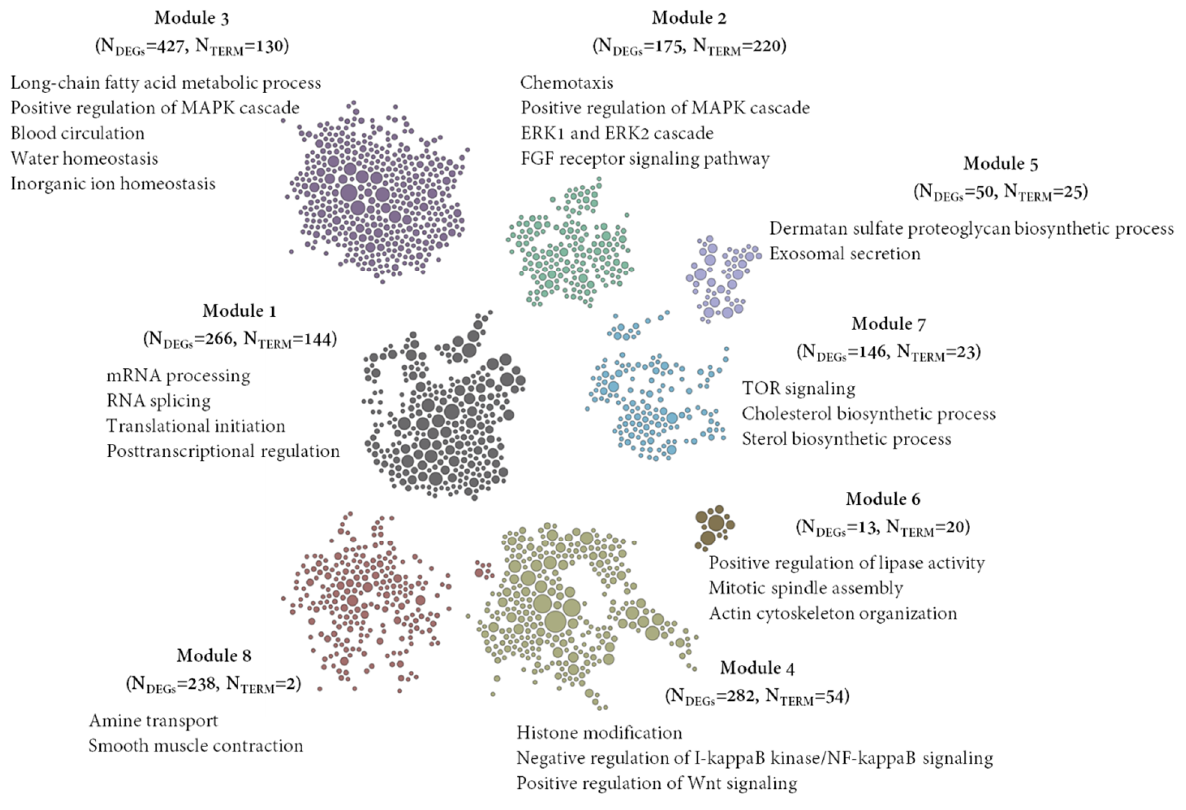
Figure 3. Functionally clustered modules by the DEGs based on shared k-nearest-neighbors and the Louvain community-finding algorithm using the HumanBase public database (https://hb.flatironinstitute.org//, accessed on 22 October 2021). Significantly enriched Gene Ontology biological process (GOBP) terms of each module are presented. Significance was calculated using Fisher’s exact tests followed by Benjamini–Hochberg corrections. N TERMs = Number of enriched GOBP terms in each module, N DEGs = number of differentially expressed genes in each module.